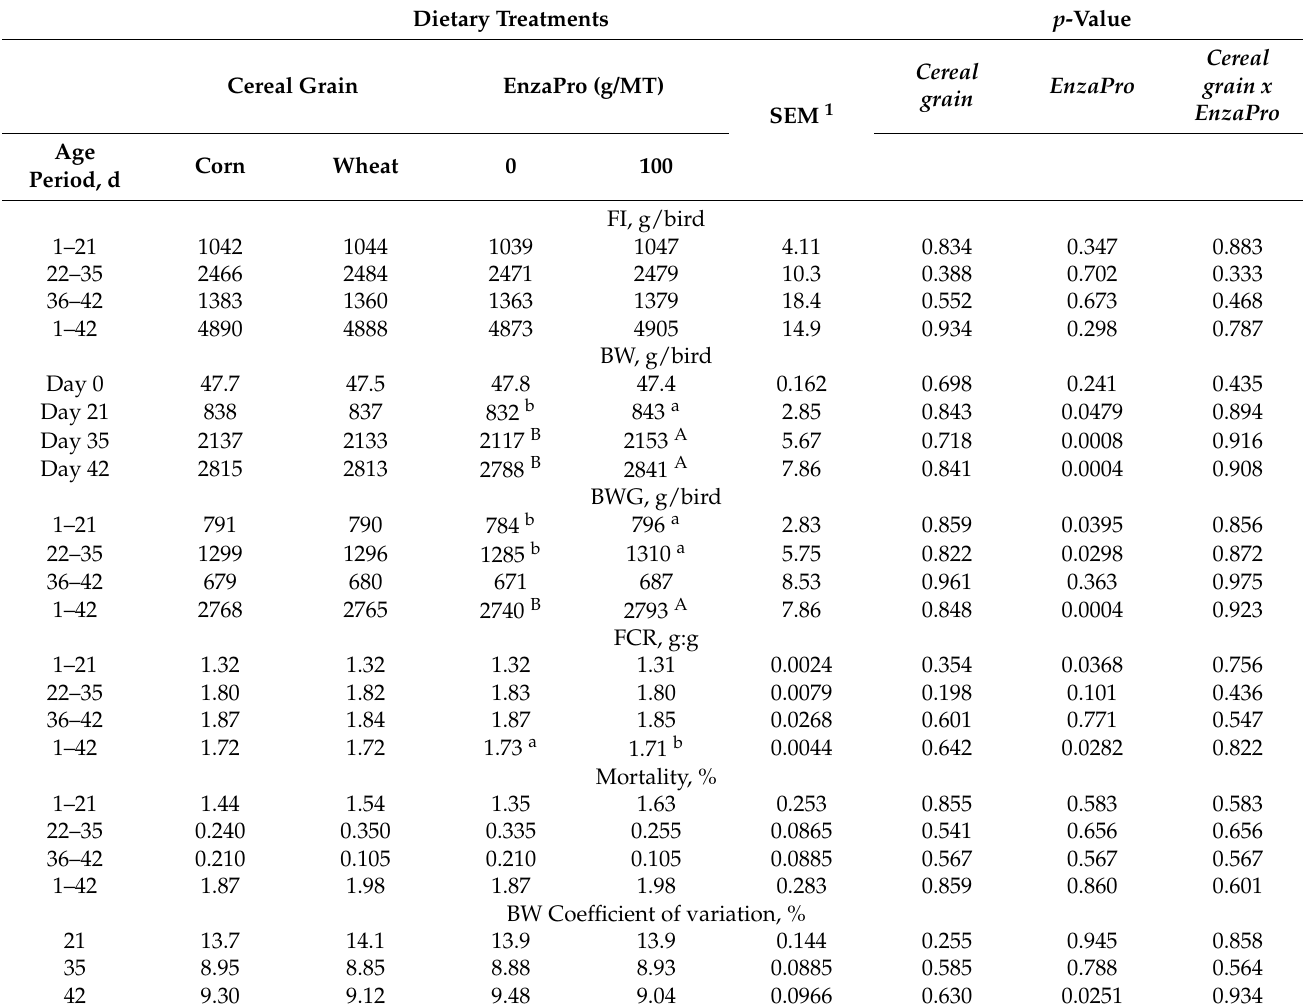
Table 2. Least-square means for feed intake (FI), body weight (BW), body weight gain (BWG), feed conversion ratio (FCR) corrected for mortality, mortality, and BW coefficient of variation for broilers raised to 42 d.